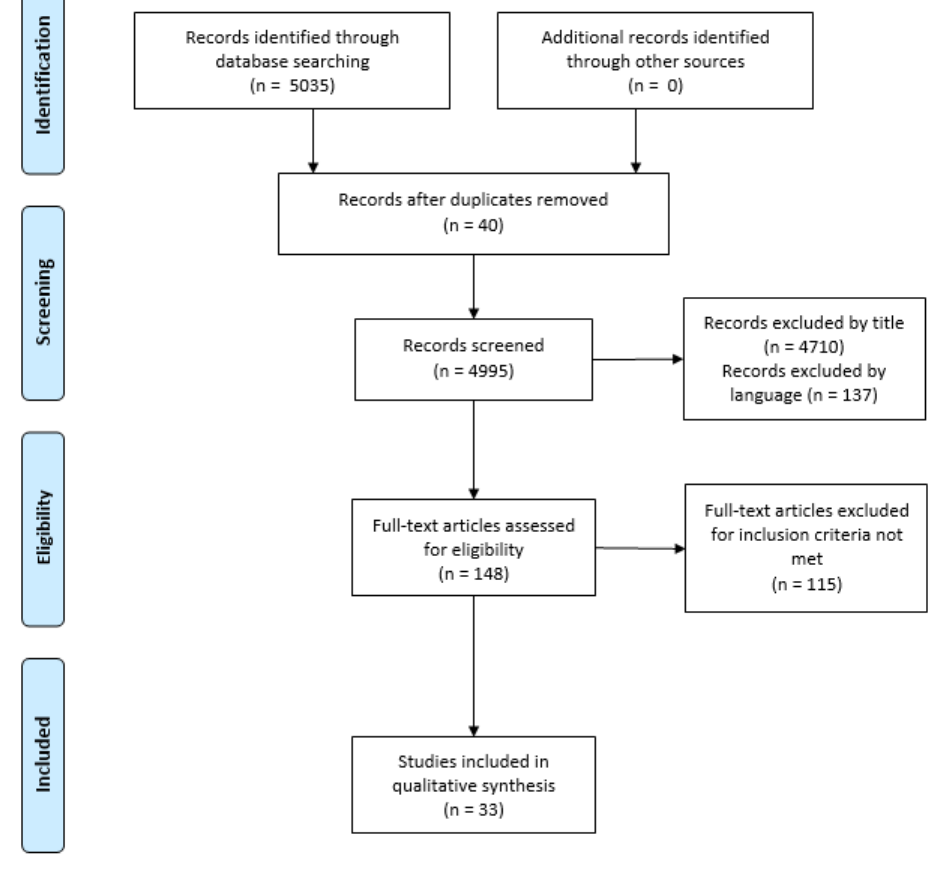
Figure 1. PRISMA Flowchart.